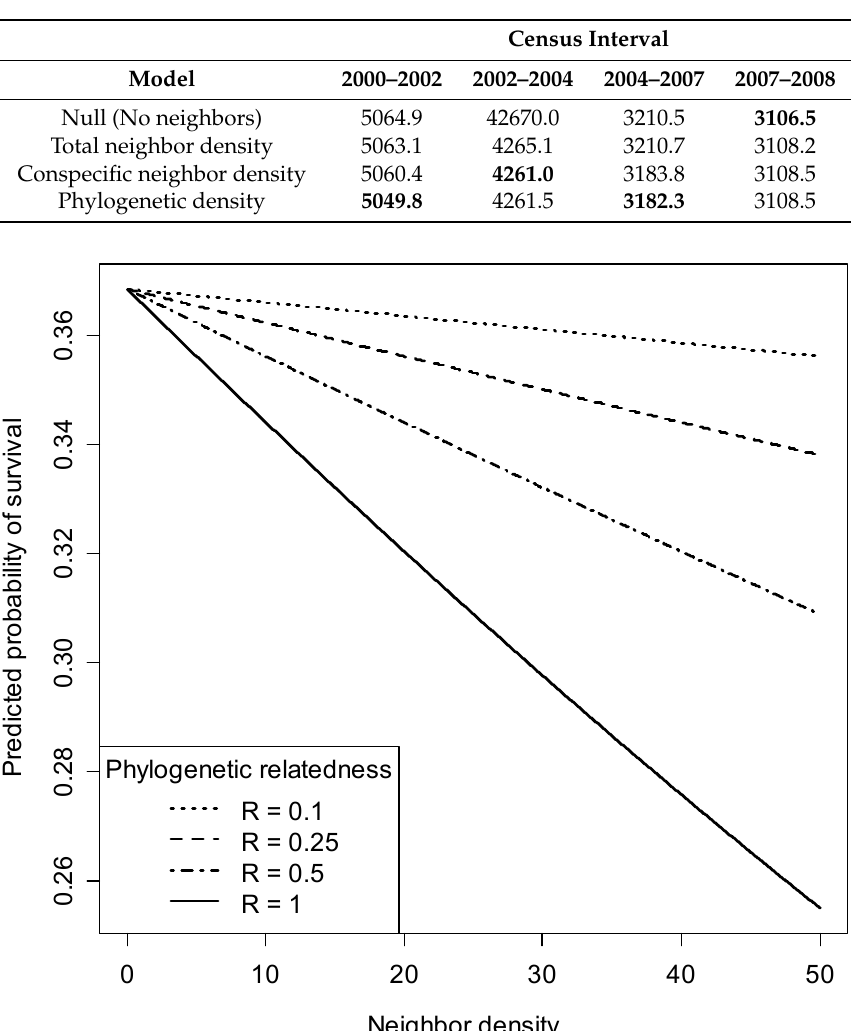
Figure 3. Effect of neighbor density on the probability of survival for a 10 cm tall seedling from 2000 to 2002 in the Luquillo Forest Dynamics Plot. Lines show the predicted relationship based on model results for different degrees of phylogenetic relatedness (R) between the focal individual and neighboring seedlings (with R = 1 for conspecifics).